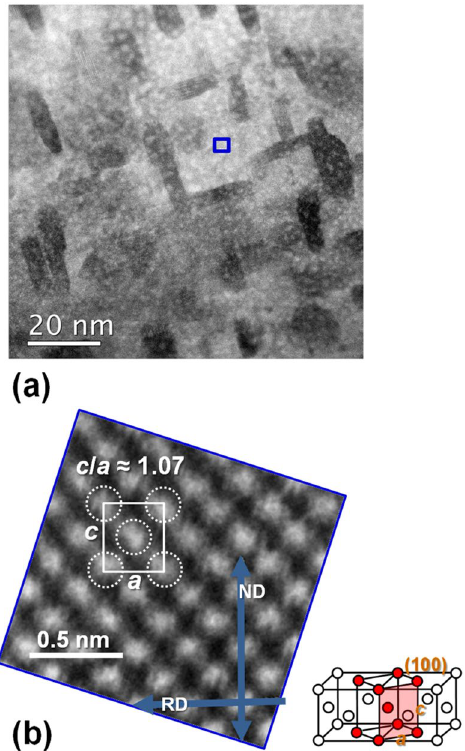
Figure 5. Cross-sectional TEM image of ( a ) Fe–Co–V–N foil nitrided at T = 650 °C. ( b ) Enlarged image corresponding to the blue square area–enclosed in ( a ) and showing the rolling direction (RD) and the normal direction (ND). The inset shows the observed (100)-plane.